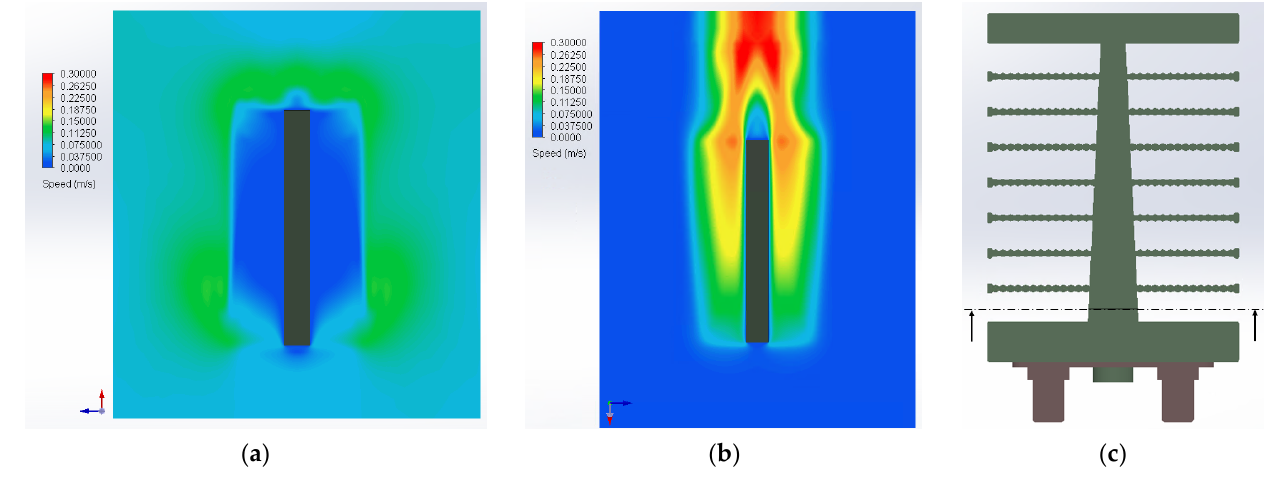
Figure 20. ( a ) Air velocity of Setup 3—section view; ( b ) Air velocity of Setup 4—section view; ( c ) Section plane.